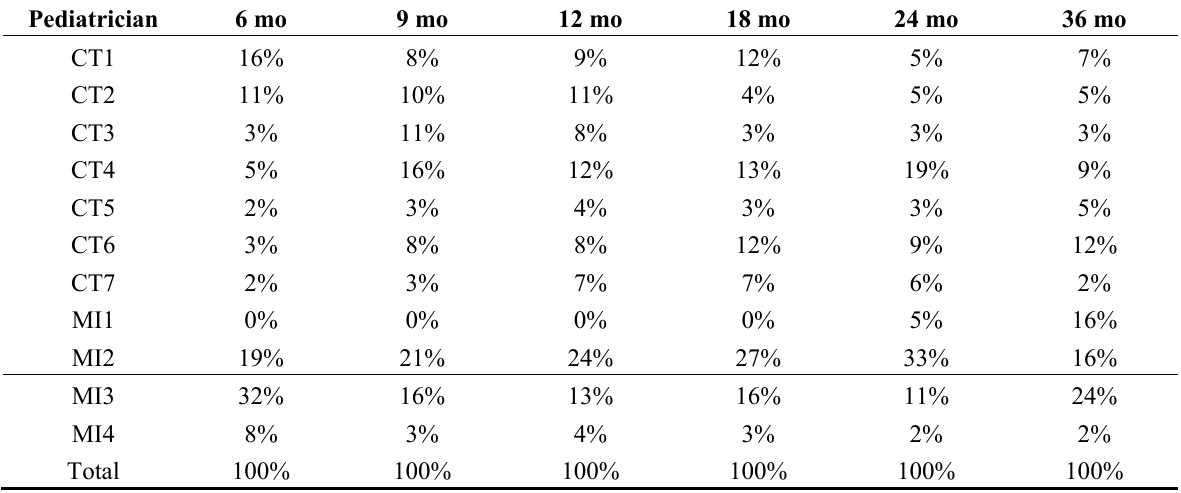
Table A1. Within-age between-pediatrician distribution of NI636